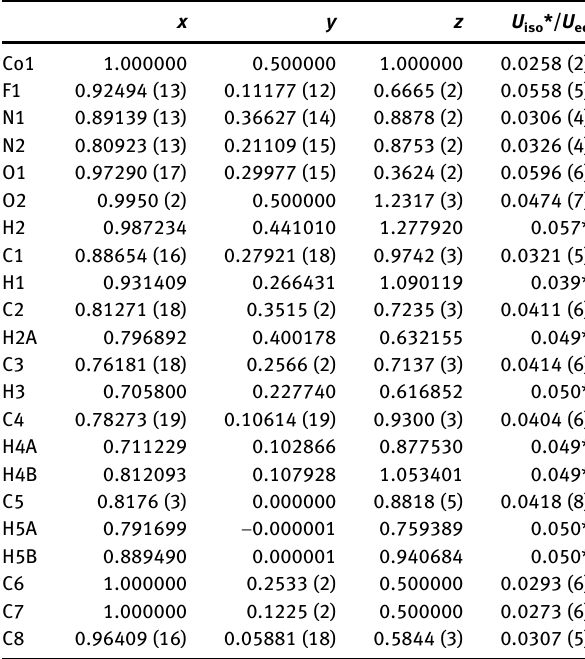
Table  : Fractional atomic coordinates and isotropic or equivalent isotropic displacement parameters (Å 